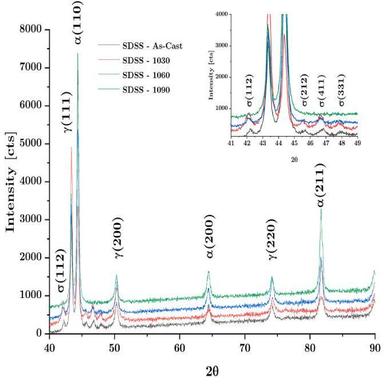
X-ray diffraction spectrum in SDSS-Nb.